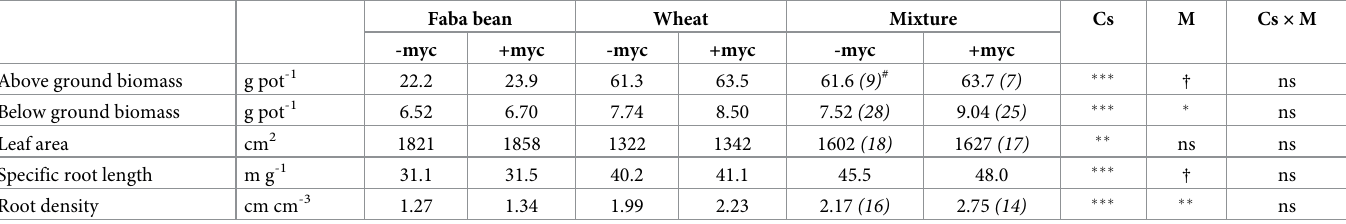
Table 1. Biomass, leaf area, and root traits in faba bean, wheat, and their mixture grown in the absence (–myc) or presence (+myc) of arbuscular mycorrhizal fungi. Cs, cropping system (faba bean, wheat, mixture); M, absence or presence of